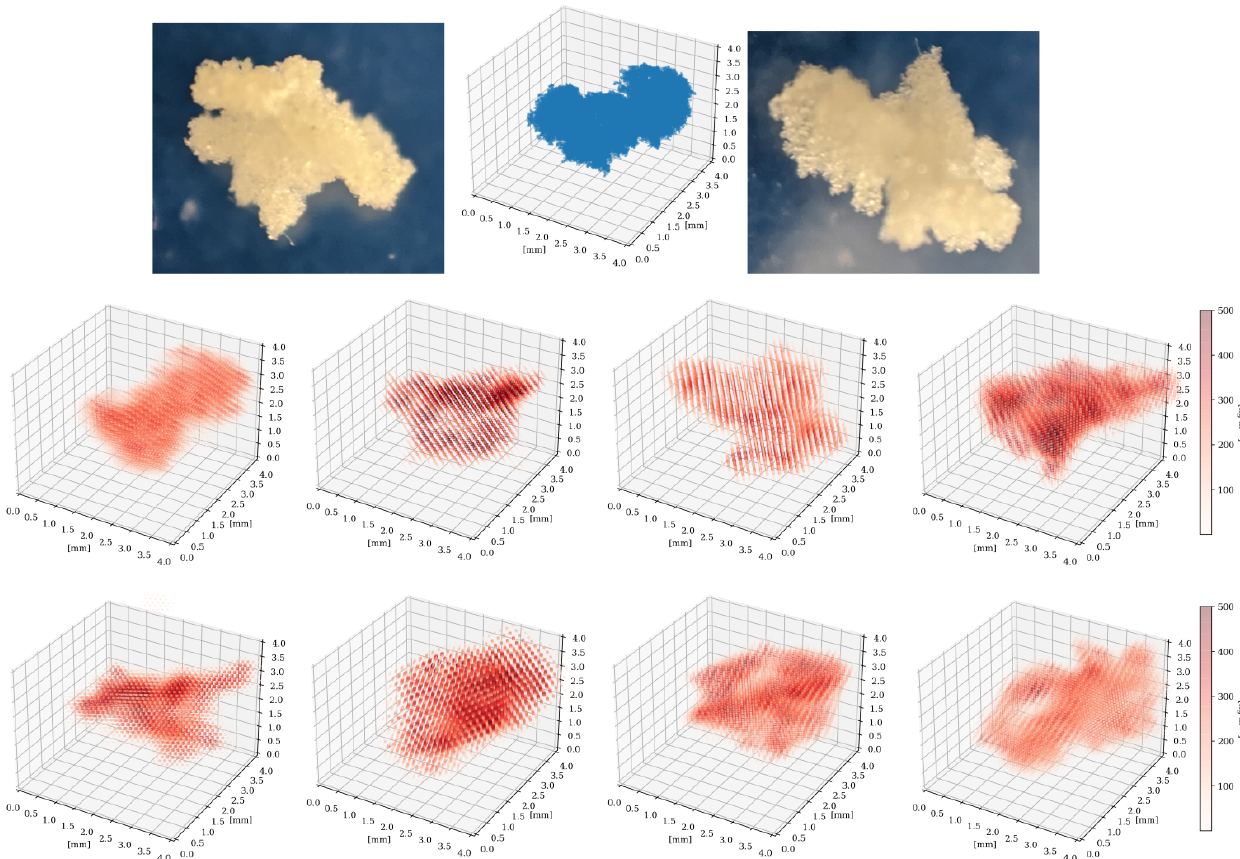
Figure 2. Example of the reconstruction outcome obtained while releasing eight consecutive times the same snowflake replica in the MASC measurement area. Top row: actual photos of the replica and a pseudo-3D representation (every blue point represents a voxel filled with ice). Bottom rows: reconstructions obtained with 3D-GAN. Every point is color-coded according to the density (ice mass content) of each